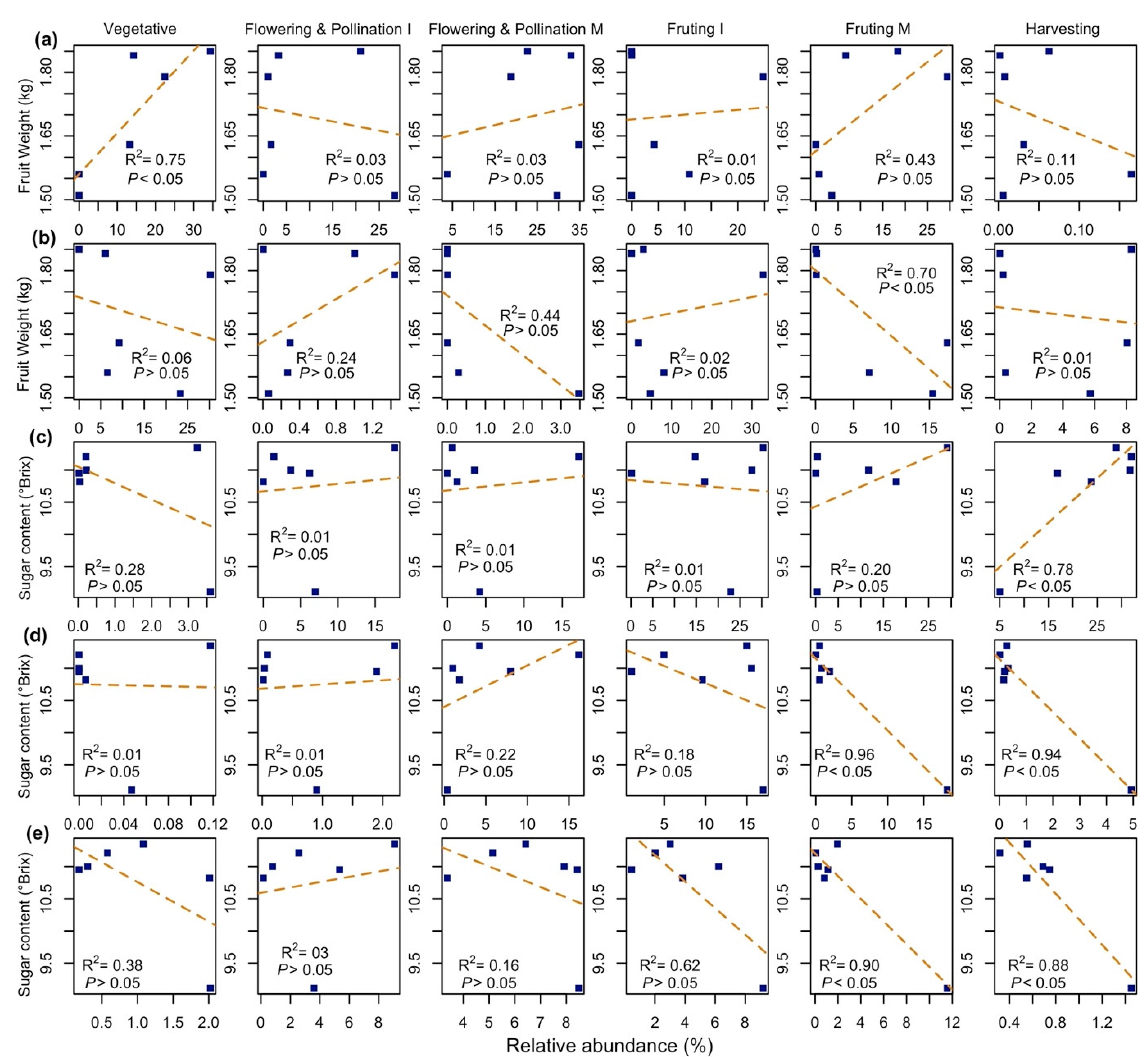
Figure 7. Linear regression between selected bacterial genera and ( a , b ) fruit weight and ( c – e ) fruit sweetness. Blue-square and orange-dotted lines indicate data points and first-order regression fit to the data set, respectively. Row ‘( a – e )’ indicate relative abundance of genera Chryseobacterium , Burkholderia_Caballeronia_Paraburkholderia , Brevibacillus , Lysobacter , and Bosea . Linear regression between all top ten dominated bacterial genera and fruit weight and fruit sweetness can be found in Figure S2 and S3 (supplementary material), respectively.